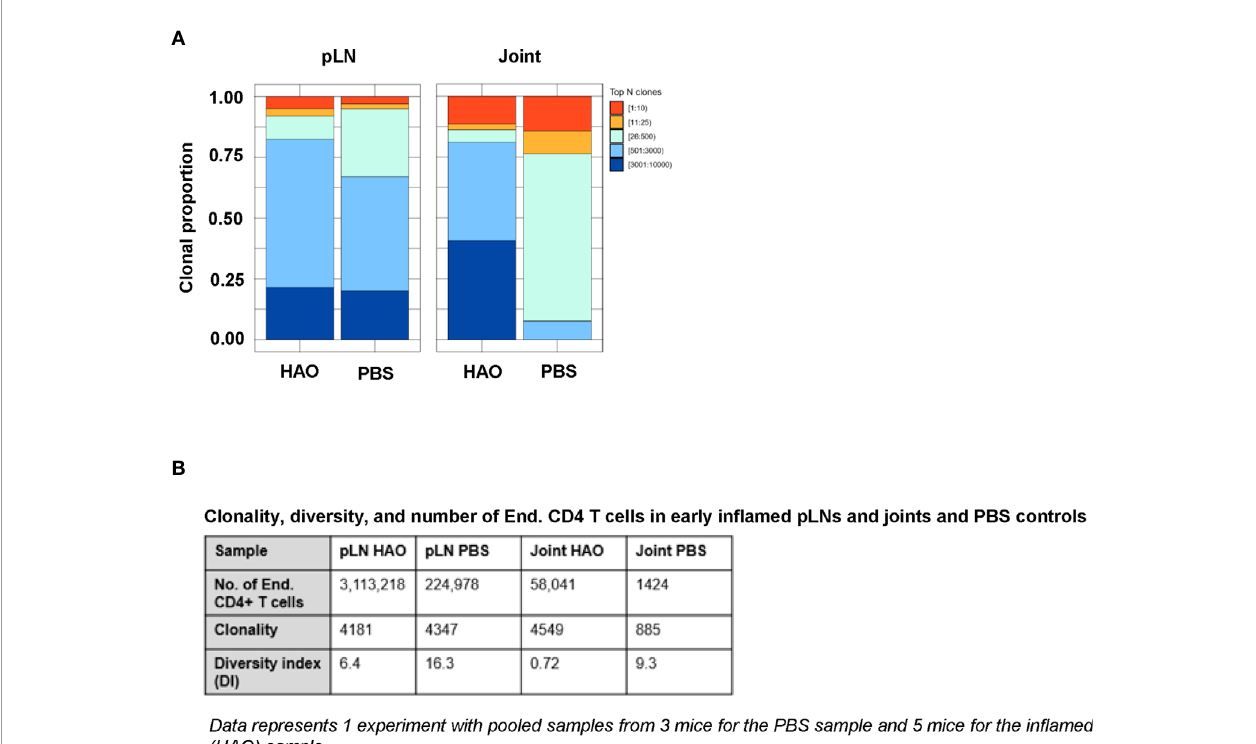
FIGURE 2 | Characterisation of antigen experienced endogenous CD4 T cell repertoires from in fl amed pLNs and joints and PBS controls at the early phase. Proportion of the top 10 most frequently occurring clones, followed by the next 25, 500, 3000, 10,000, and 100,000 most frequent clones contributing to the endogenous antigen experienced CD4+ T cell repertoire in (A) pooled in fl amed pLNs and joint samples at the early phase (HAO) and pooled PBS controls. (B) Descriptive statistics of pooled in fl amed pLN and joint samples at the early phase and their PBS controls indicating endogenous CD4 T cell number, clonality, and diversity. Data represents 1 experiment with pooled samples from 3 mice for the PBS sample and 5 mice for the in fl amed (HAO)